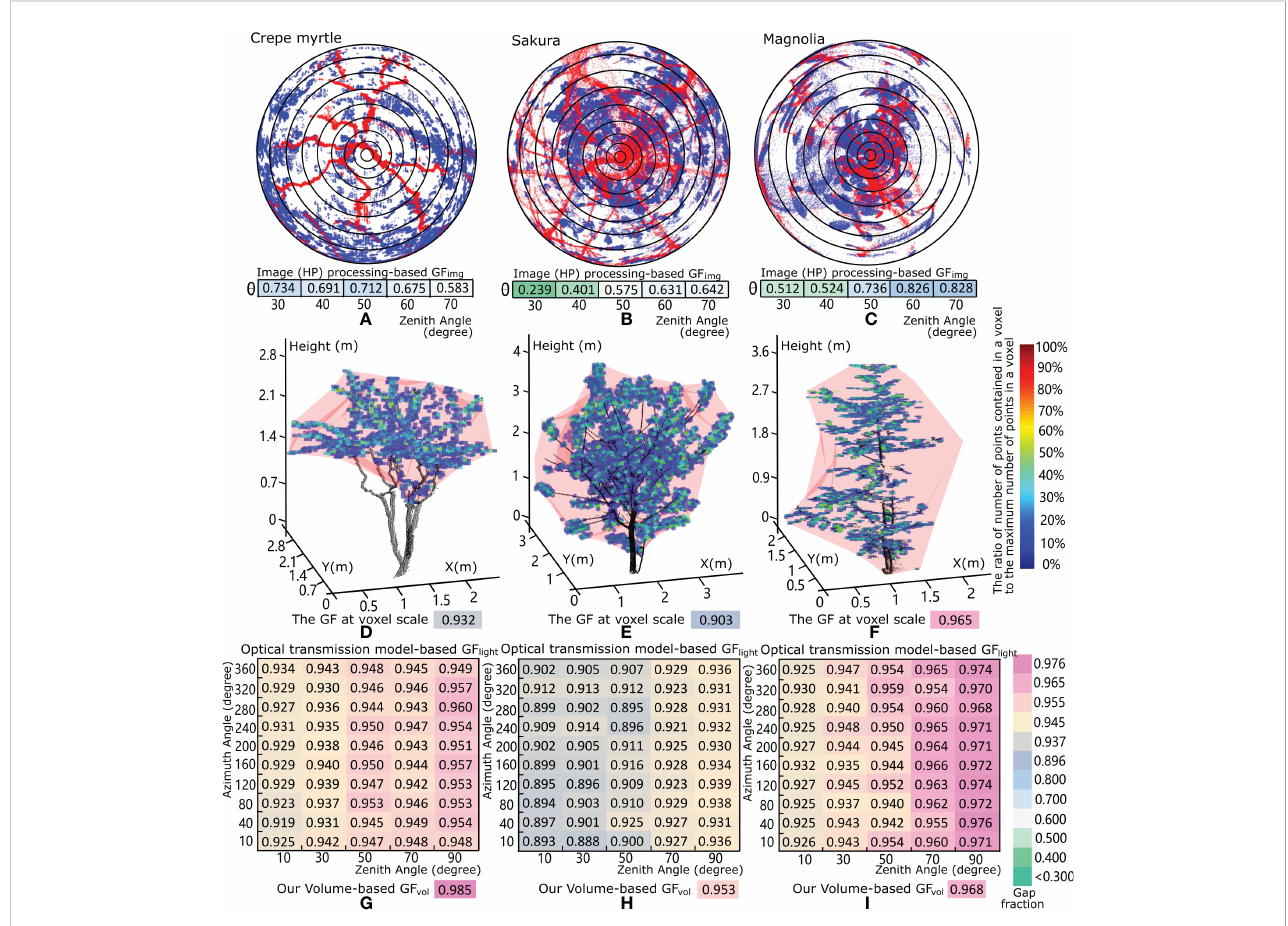
FIGURE 7 Comparison of the results of our method and two existing methods of gap fraction retrieval for the three studied trees: the crepe myrtle, sakura and magnolia trees. (A – C) , Gap fraction GF img calculations from the generated HP through a Lambert azimuthal equal-angle projection of the scanned tree points. (D – F) and 3D visualization of a cubic voxel-based representation of the three studied trees, where the different colours of each voxel represent the ratio of the number of scanned points in each voxel to the maximum number of scanned points in the voxel within the tree crown. The gap fraction at the voxel scale, i.e., the canopy volume minus the total volume of all voxels that contain scanned tree points, divided by the canopy volume for each tree crown is shown in (D, E) . (F – I) show the matrix of gap fraction GF light results for each tree crown based on the optical transmission method, which varies with different azimuth and zenith angles of emitted light. The GF vol values are roughly equal to those of our volume-based method when the zenith angle of the emitted light is